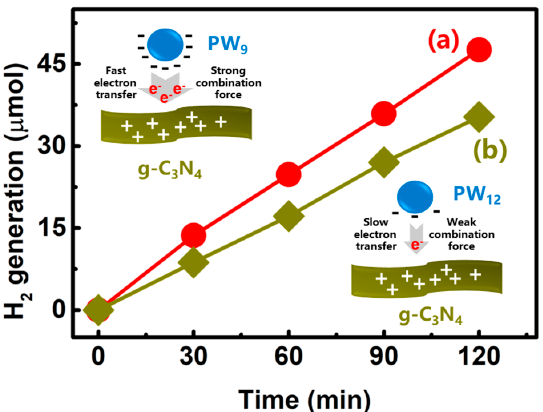
Figure 6. Time-dependent photocatalytic H 2 -generation plots over (a) PW 9 /g-C 3 N 4 heterojunction NSs and (b) PW 12 /g-C 3 N 4 heterojunction NSs upon simulated sunlight irradiation. The insets showing the interfacial adsorption and electron transfer abilities of the PW 9 /g-C 3 N 4 heterojunction and PW 12 /g-C 3 N 4 heterojunction NSs.